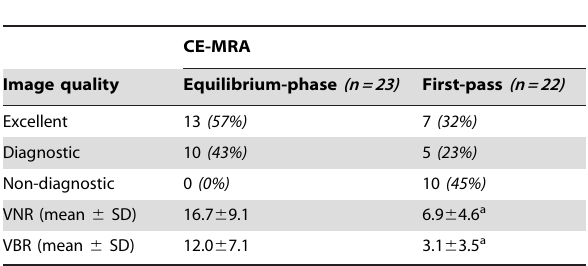
Table 2. Image quality in